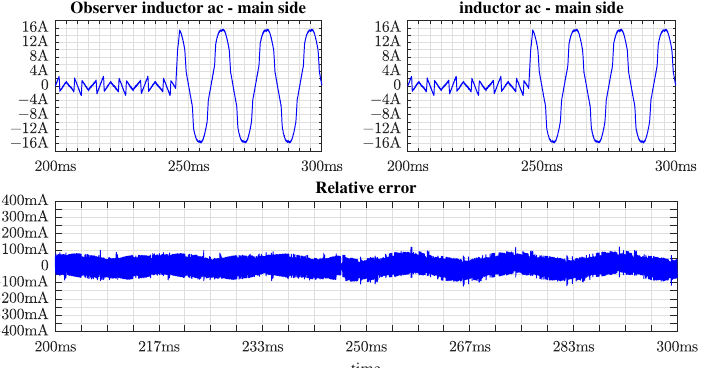
Figure 9. Current waveforms: Observer inductor ac-main side, inductor ac-main side, and relative observer